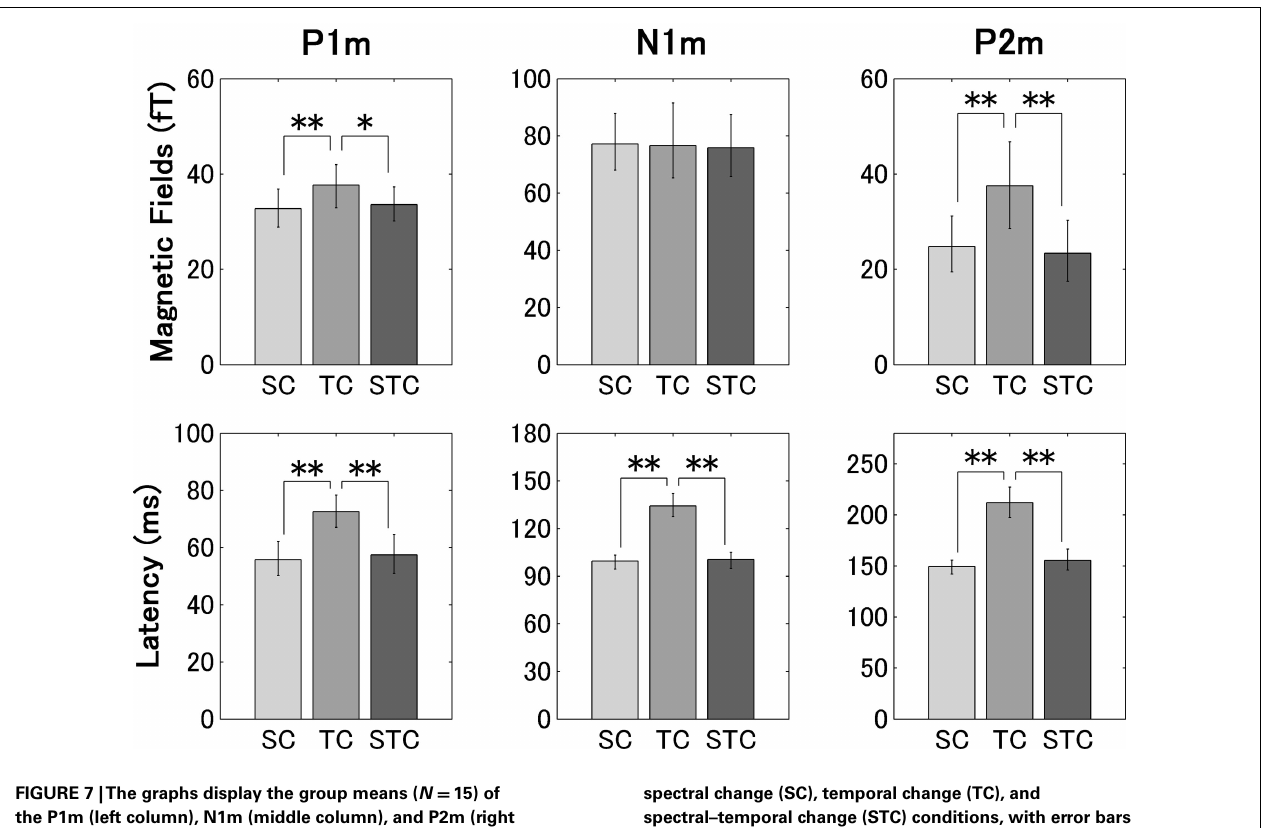
FIGURE 7 |The graphs display the group means ( N = 15) of the P1m (left column), N1m (middle column), and P2m (right column) root-mean-square (RMS) amplitudes (upper row), and latencies (lower row) after the sound changes for the